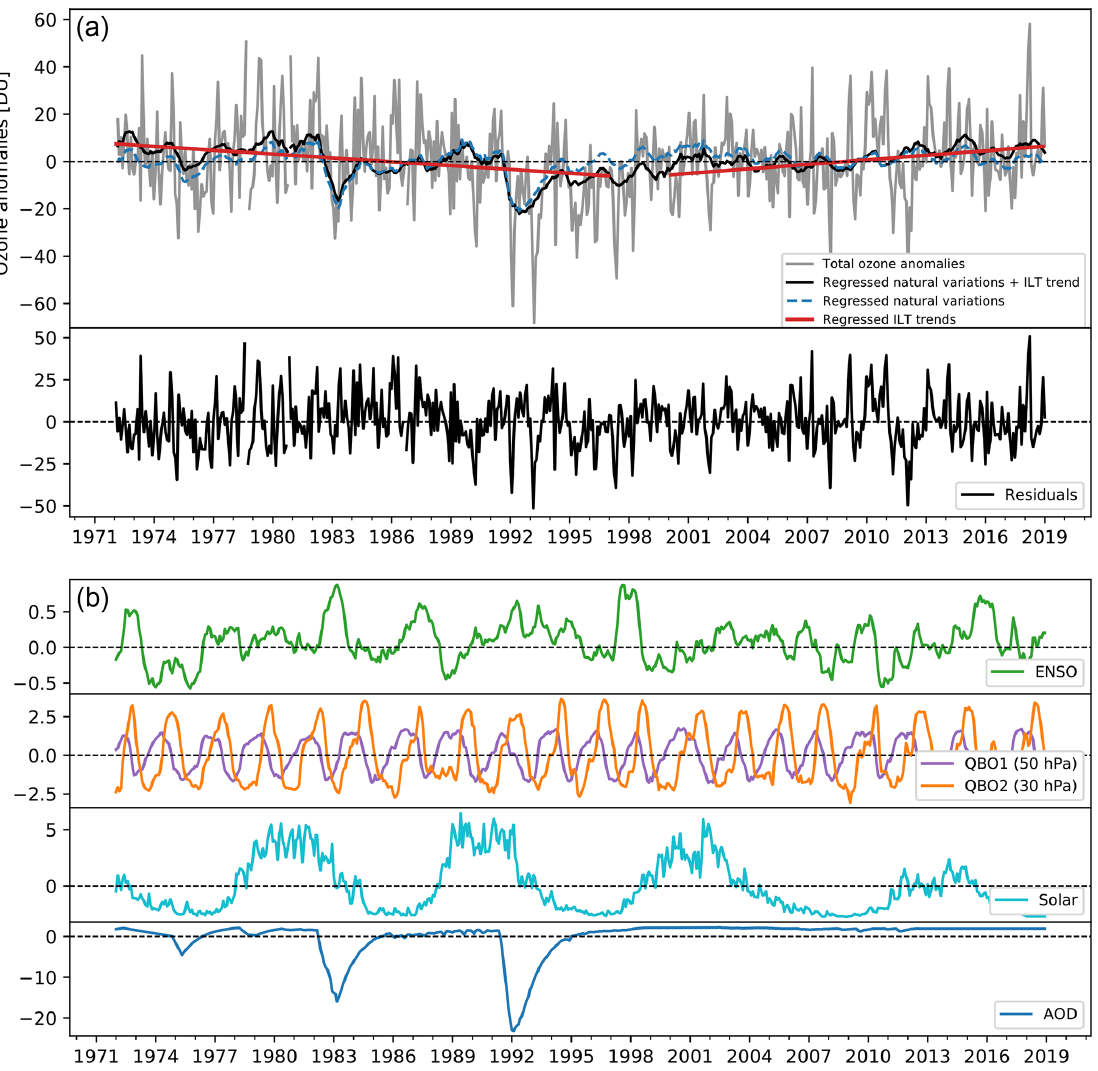
Figure A2. Terms in the LOTUS multiple linear regression model for the Uccle total ozone amounts. Panel (a) shows the observed total ozone monthly anomalies in grey. The black line is the result of the full LOTUS regression model including the independent linear trends (ILTs, thick red lines). The pre-1997 trend equals − 1.6 ± 0.5% per decade, and the post-2000 trend equals + 1.9 ± 0.8% per decade. The dashed blue line shows the sum of the terms of the LOTUS model without the ILTs included. The bottom of panel (a) shows the residuals in the observed ozone concentrations with the full LOTUS model subtracted. Panel (b) shows the contributions (from top to bottom) of ENSO, QBO, the solar cycle, and aerosols to the reconstructed time series (blue dashed line) in panel (a)